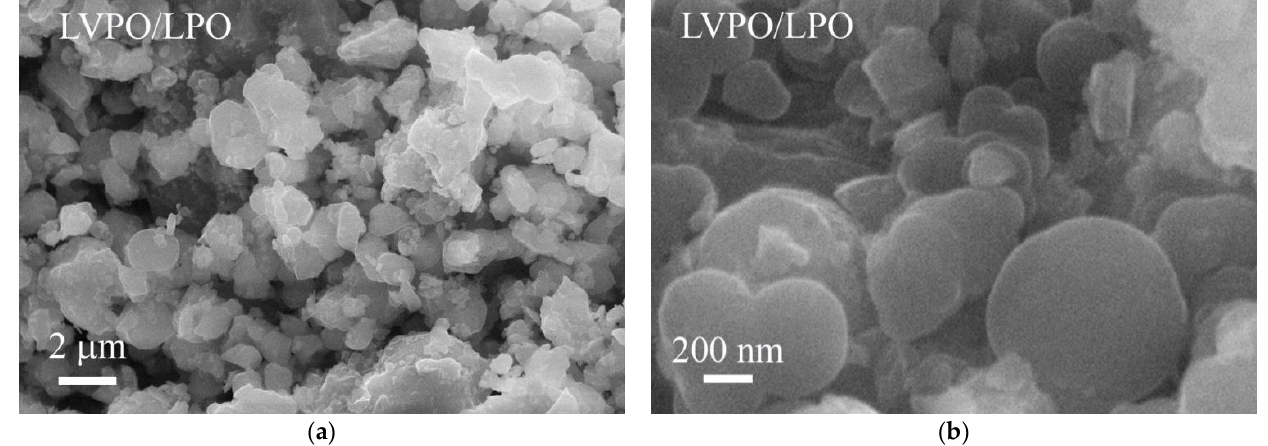
Figure 2. SEM images of the Li 3 V 2 (PO 4 ) 3 /Li 3 PO 4 composite at different magnification.